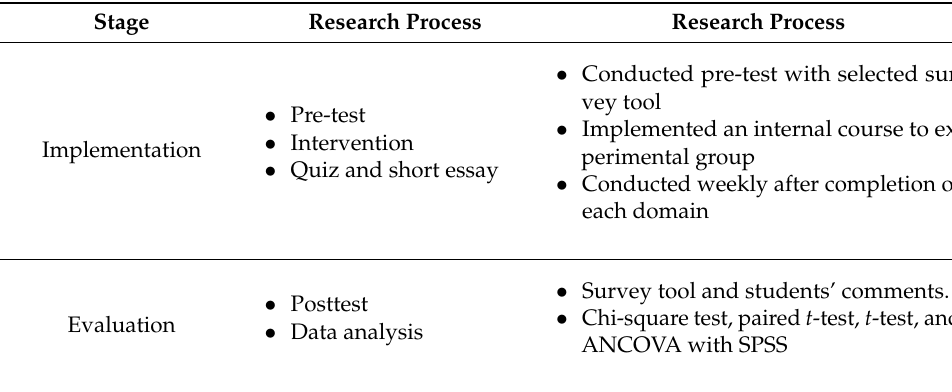
Table 3. Evaluation of the Course on Global Health